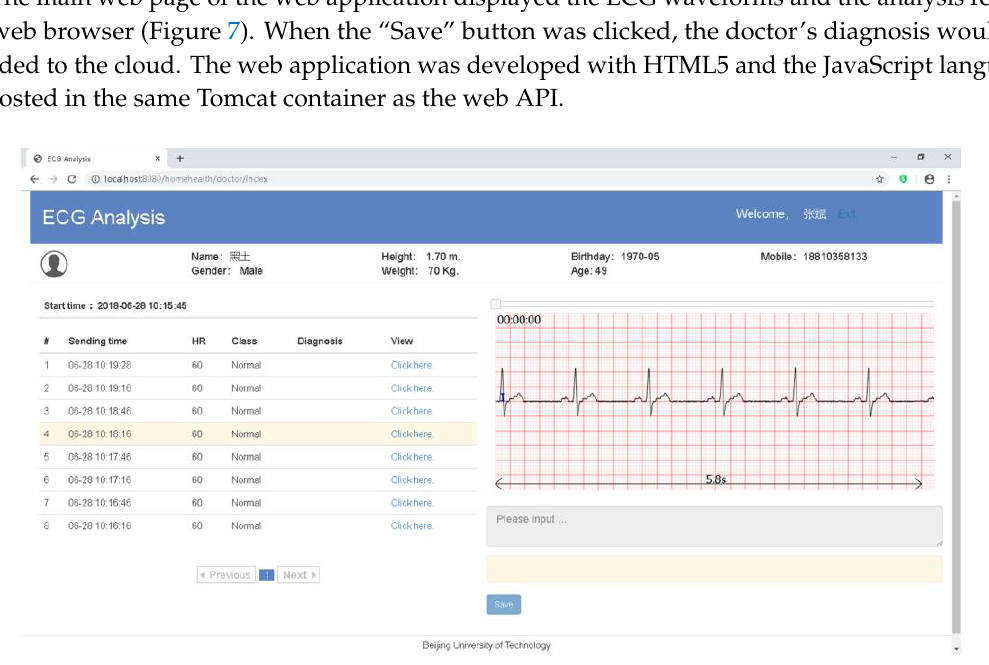
Figure 8. Flow chart of the web application of ECG diagnosis.